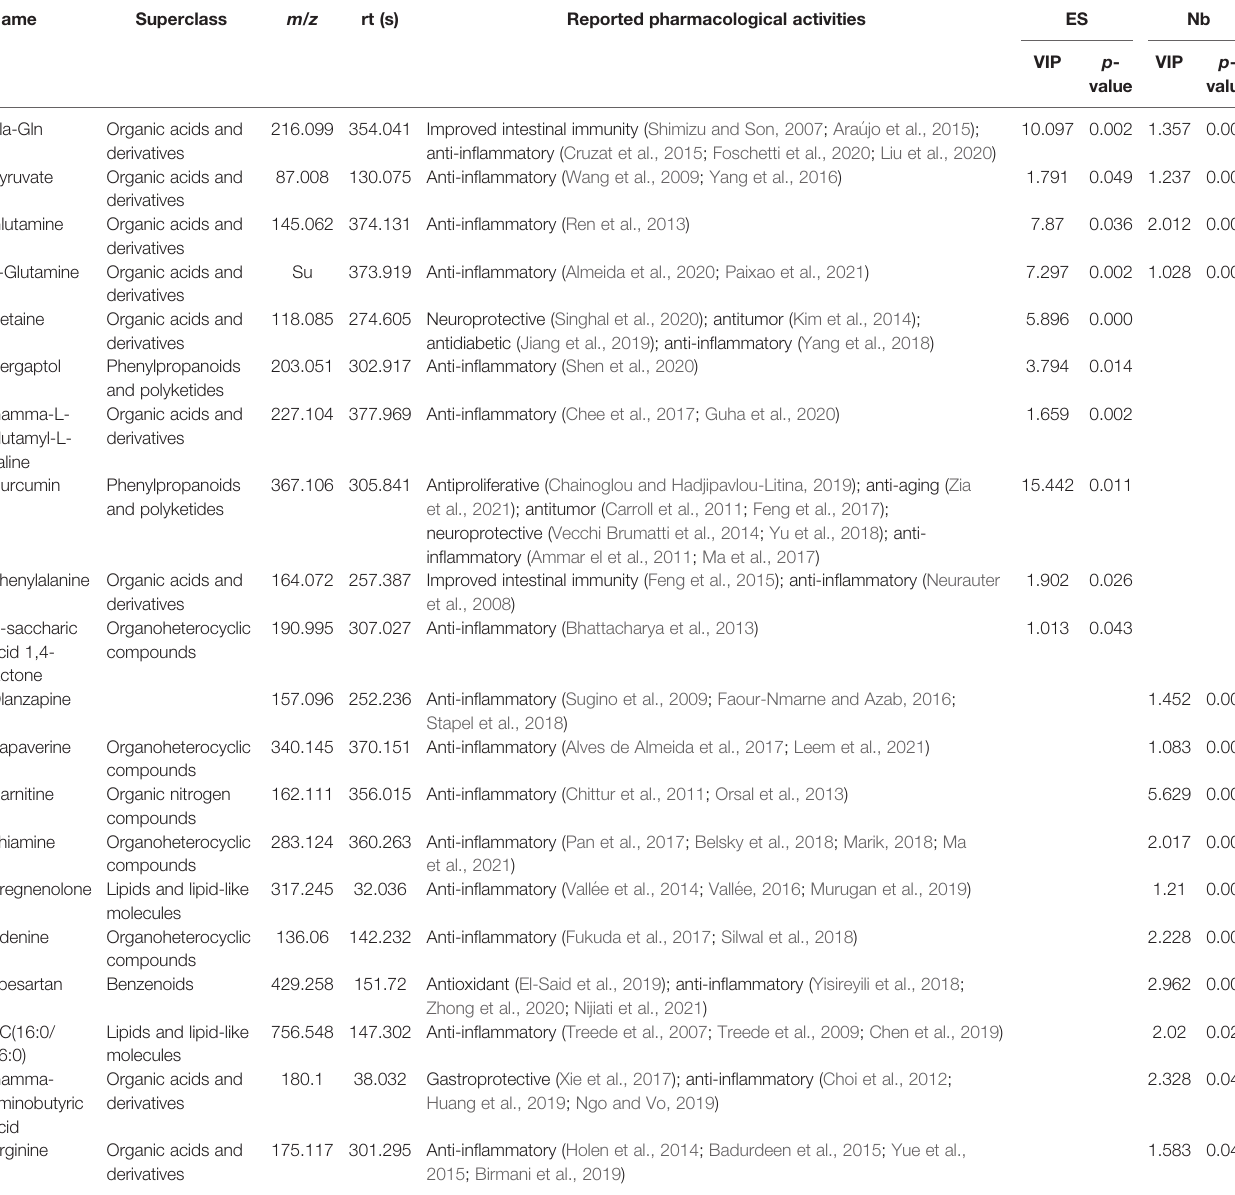
TABLE 2 | Summary table of differential metabolites with pharmacological